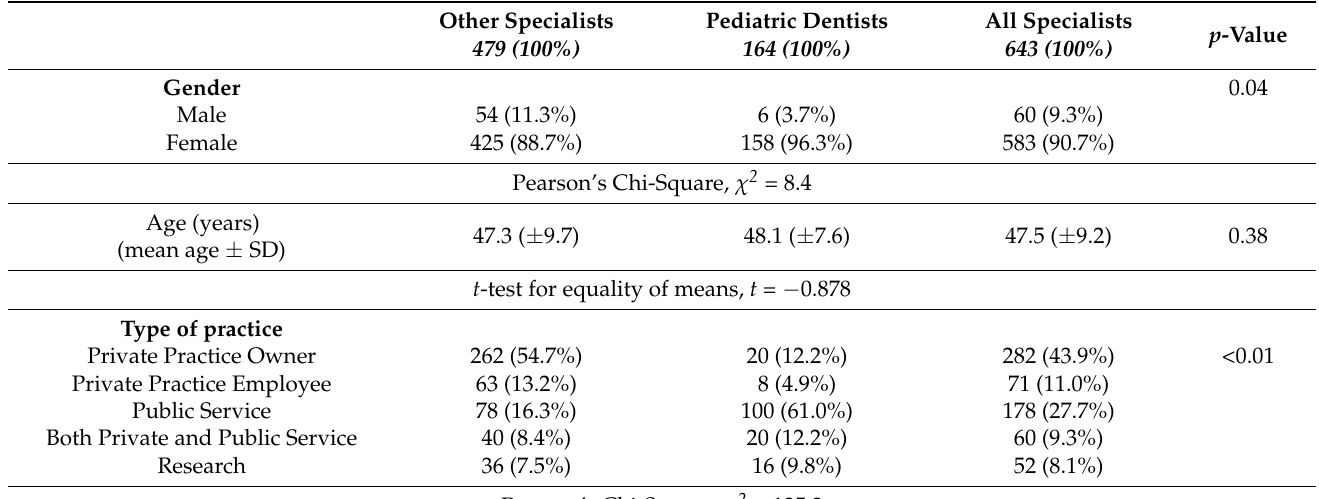
Table 2. Sample summary.